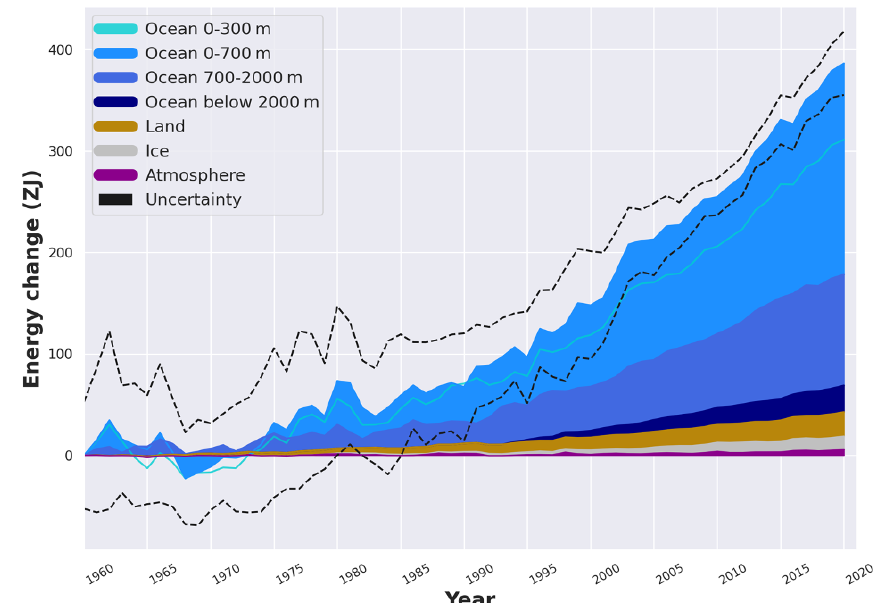
Figure 8. Total Earth system heat gain inZJ (1ZJ = 10 21 J) relative to 1960 and from 1960 to 2020. The upper ocean (0–300m, light blue line, and 0–700m, light blue shading) accounts for the largest amount of heat gain, together with the intermediate ocean (700–2000m, blue shading) and the deep ocean below 2000m depth (dark blue shading). The second largest contributor is the storage of heat on land (orange shading), followed by the gain of heat to melt grounded and floating ice in the cryosphere (gray shading) and heating of the atmosphere (magenta shading). Uncertainty in the ocean estimate also dominates the total uncertainty (dot-dashed lines derived from the standard devi- ations (2 σ ) for the ocean, cryosphere, land, and atmosphere). See Sects. 2–5 for more details of the different estimates. The dataset for the Earth heat inventory is published at the German Climate Computation Centre (DKRZ; https://www.dkrz.de/, last access: 29 March 2023) (see Sect. 7). Consistent with von Schuckmann et al. (2020), we obtain a total heat gain of 381 ± 61ZJ over the period 1971–2020, which is equivalent to a heating rate (i.e., the EEI) of 0 . 48 ± 0 . 1Wm − 2 applied continuously over the surface area of the Earth (5 . 10 × 10 14 m 2 ). The corresponding EEI over the period 2006–2020 amounts to 0 . 76 ± 0 . 2Wm − 2 . The LOWESS method and associated uncertainty evaluations have been used as described in Sect.